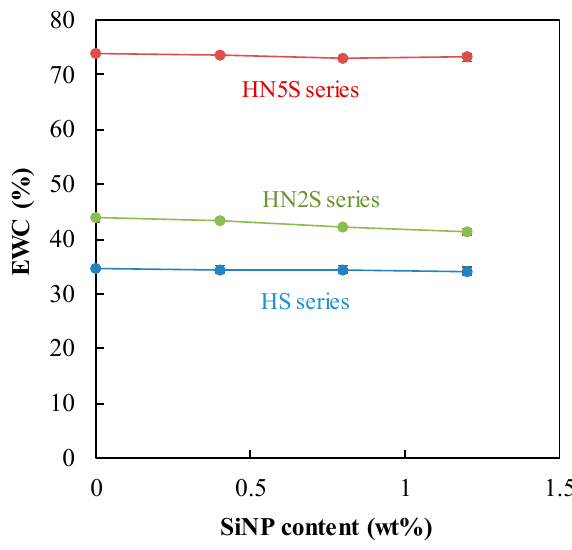
Figure 10. EWC of SiNPs samples.